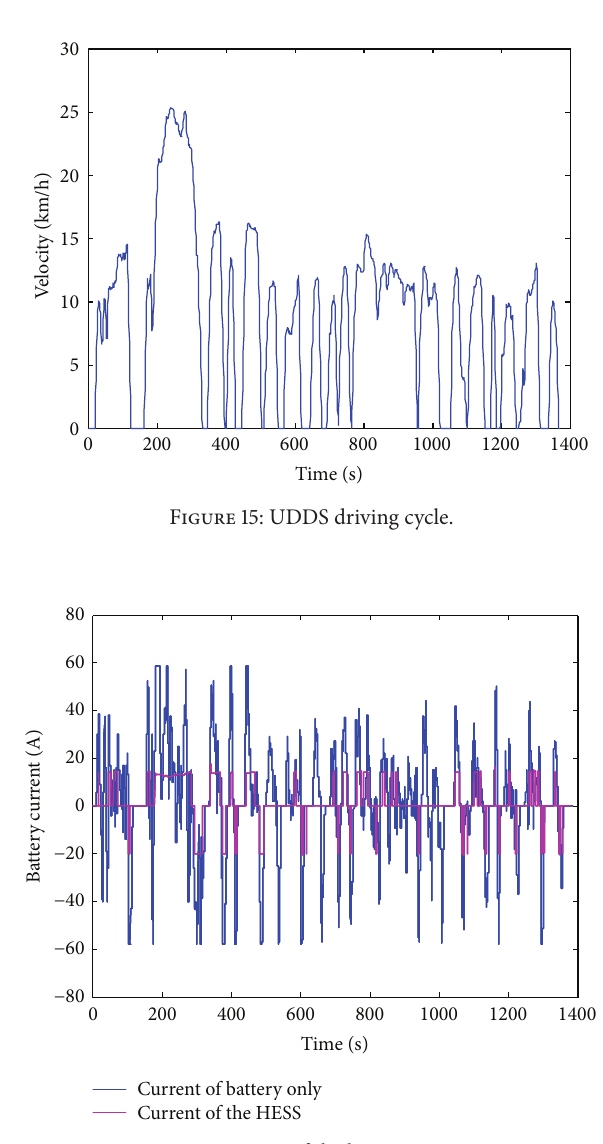
Figure 16: Comparison of the battery current curves.